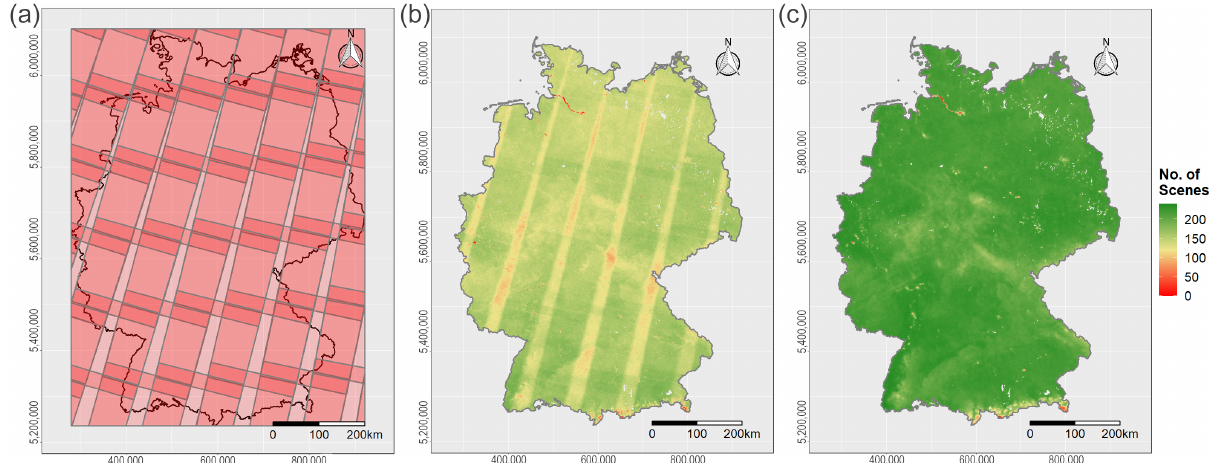
Figure 12. Number of monthly median images after cloud, cloud shadow and snow masking since the year 2000. Landsat imagery ( b ) exhibits inconsistent data frequency across Germany, while MODIS data ( c ) features overall more homogeneous and higher data frequency. Areas with lower numbers of available Landsat scenes overlap with tile gaps of the Worldwide Reference System (WRS) as seen in ( a